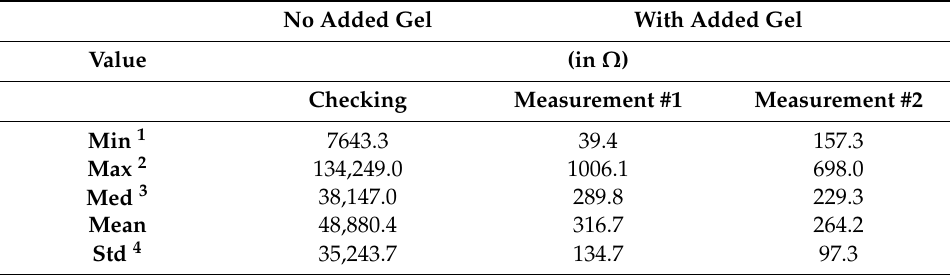
Table 1. Global behaviour of dataset of contact